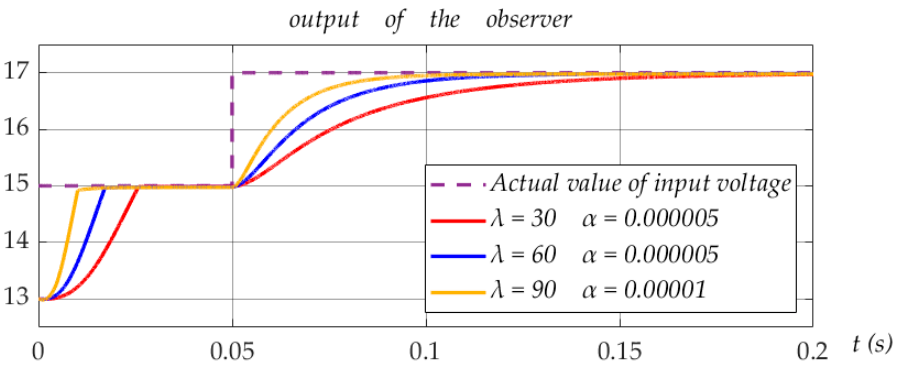
Figure 7. Response curves of the proposed observer with different λ and α .